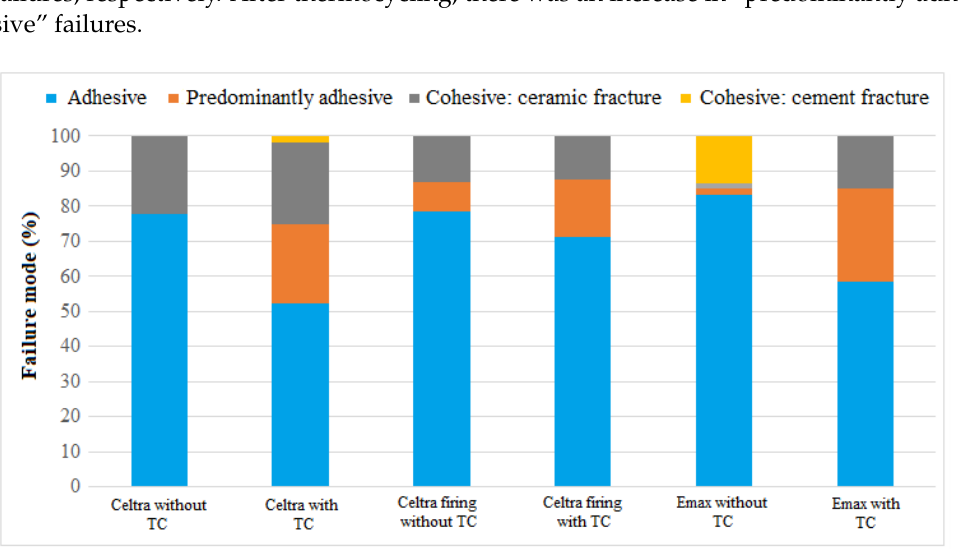
Figure 4. Bar graph of failure modes distribution (TC =